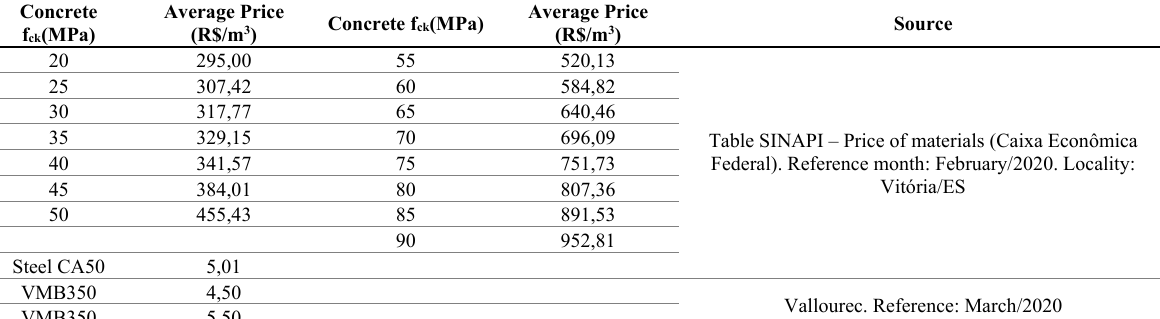
Table SINAPI – Price of materials (Caixa Econômica Federal). Reference month: February/2020.